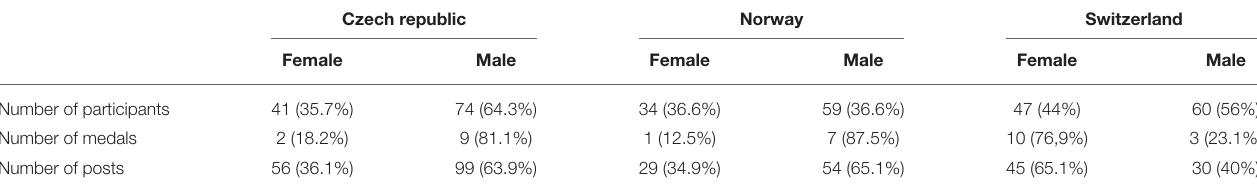
TABLE 2 | Number of participants, medals, and